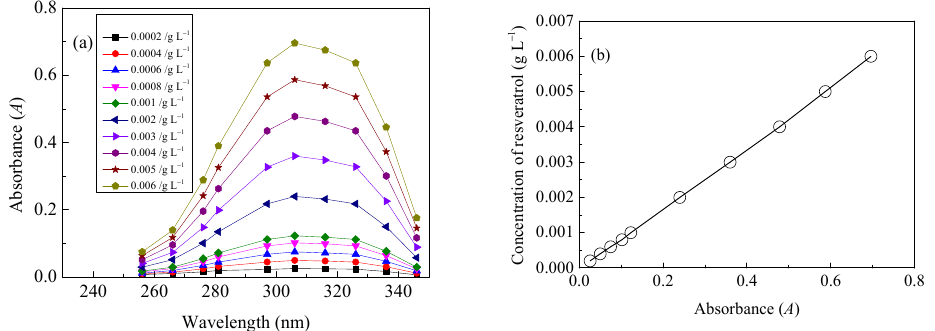
Figure 3. The ultraviolet spectra: ( a ) The calibration curve; ( b ) Quantitative measurement of resveratrol in a solvent of ethanol.